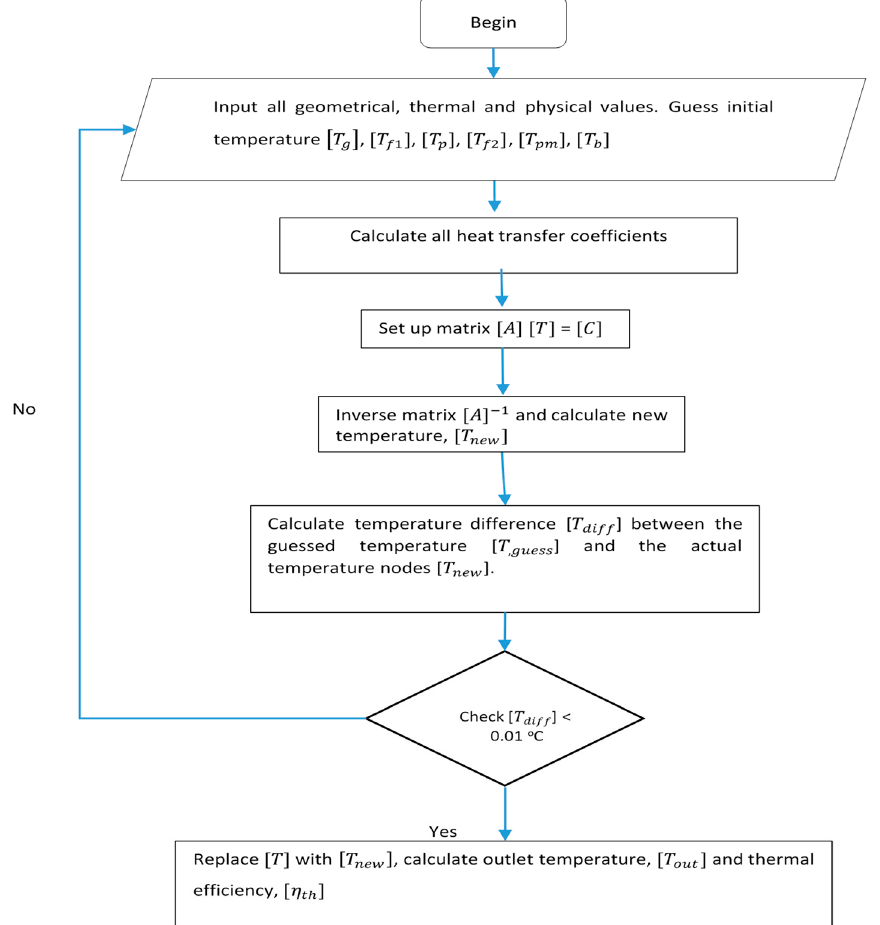
Figure 5. Computer iteration method using MATLAB.